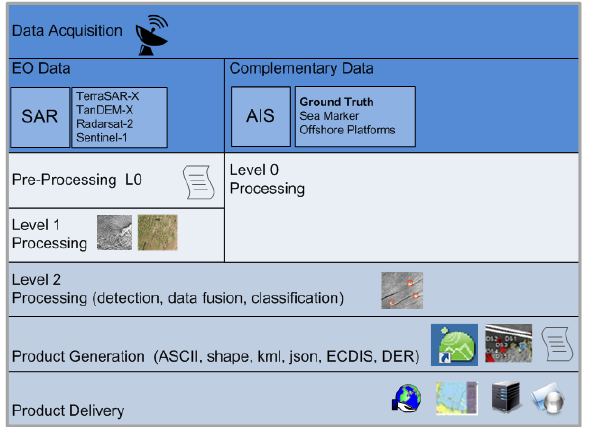
Figure 2. Workflow to supply satellite-based maritime information products (current status)